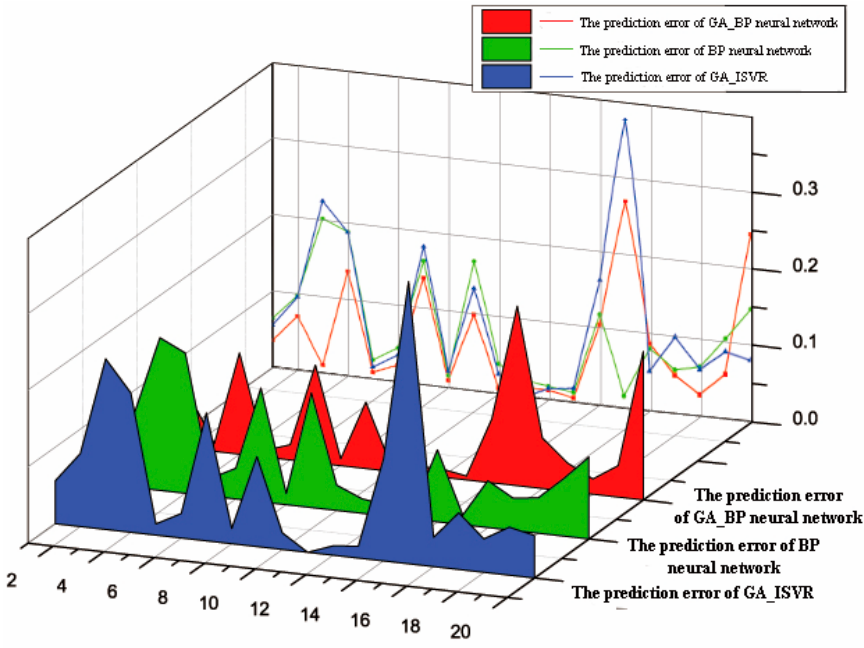
Figure 15. Schematic diagram of comparison between overbreak errors.